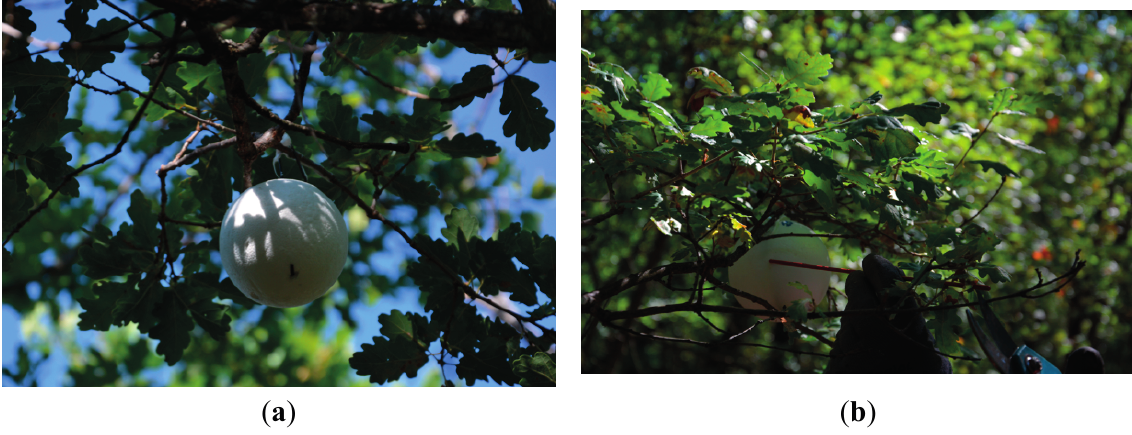
Figure 2. Picture of a target used to locate the center of a calibration volume (CV). ( a ) A polystyrene ball target and ( b ) removing material outside the CV before leaf